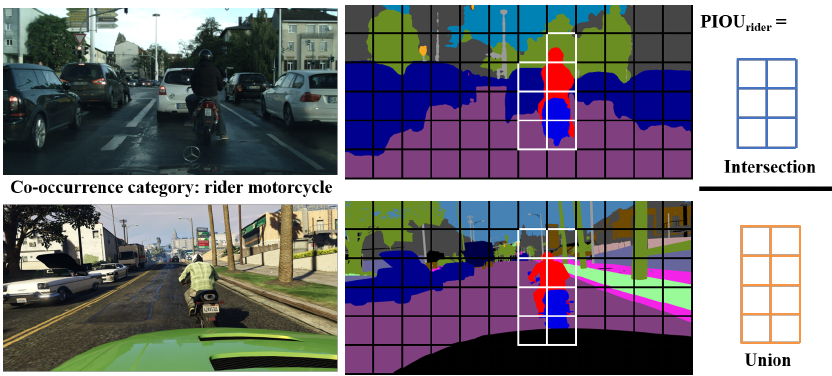
Figure 5. Visualization of PIOU